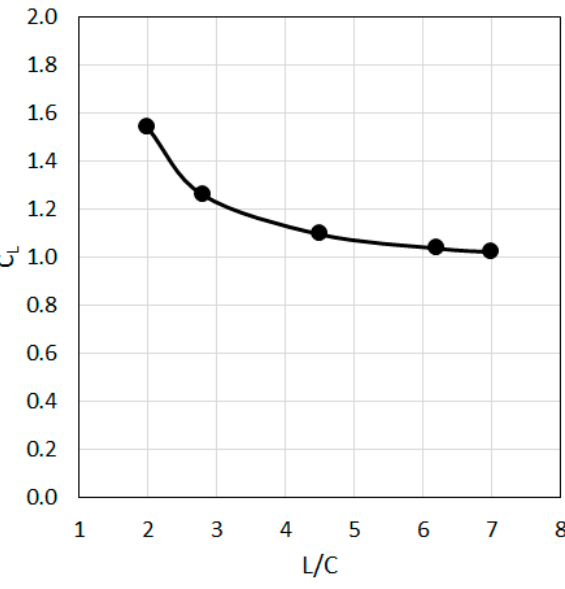
Figure 7. Variation of the predicted lift coefficient with circumferential domain size, for Re = 400,000, BA = 5°, FA = 15° (AoA = 10°).